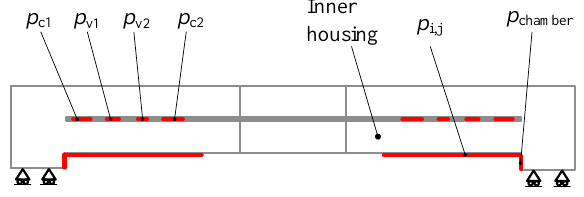
pressures and boundary